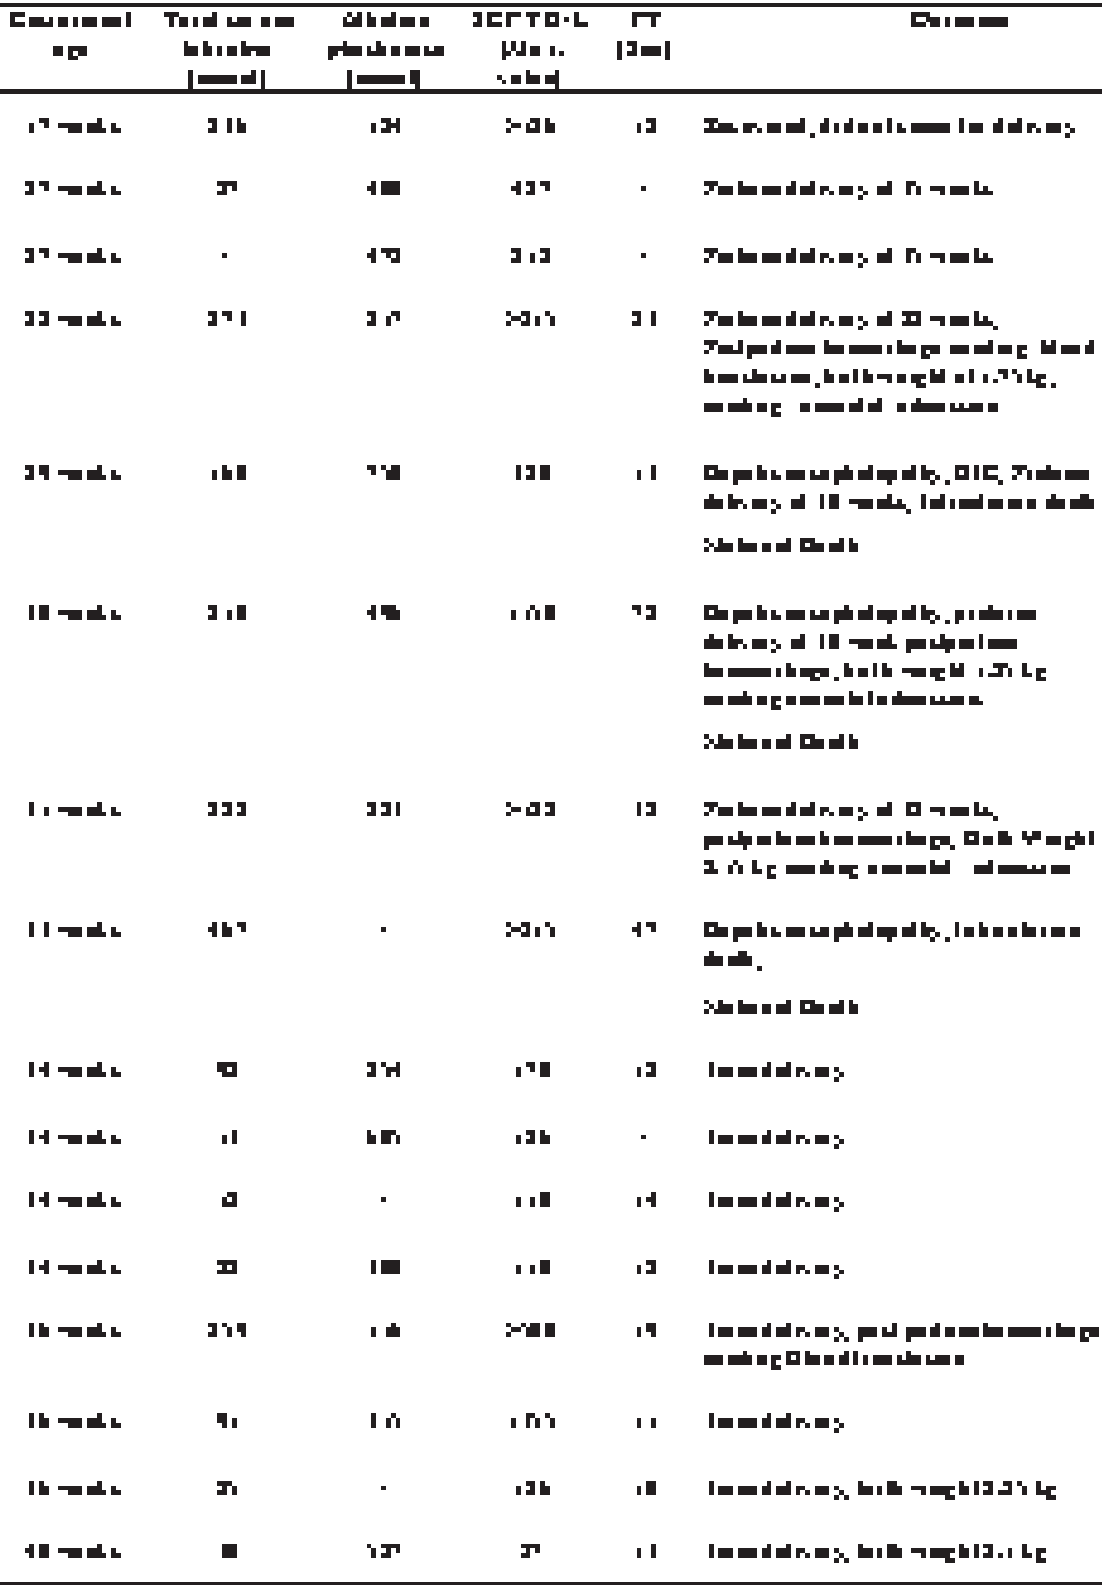
Table I: Liver function tests and relationship with